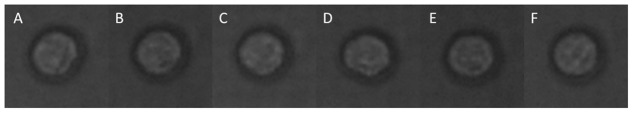
Rotation of melan-a.Time lapse for a melan-a cell completing one revolution with the applied frequency of 40 kHz at 6 Vpp as recorded by a CCD camera after grey-scale treatment. The similarity coefficients were 1 (A), 0.9973 (B), 0.9964 (C), 0.99656 (D), 0.9951(E) and 0.9963(F). Images were taken 0.155 seconds apart. The rotational speed was recorded as 65 rpm.